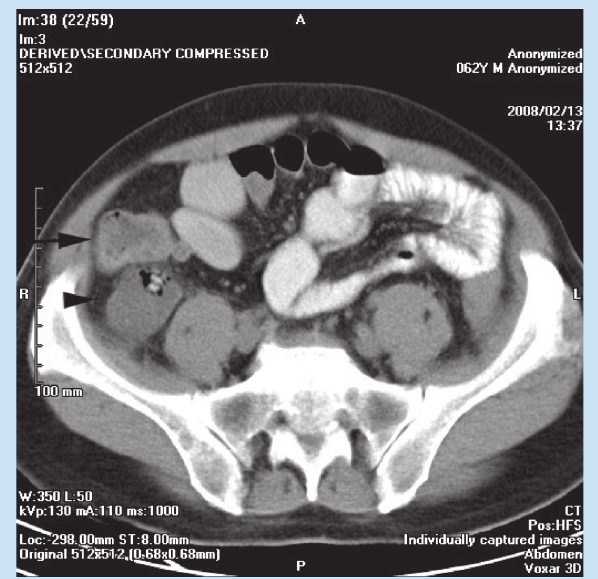
Fig. 2. CT scan of the abdomen. Retrocaecal collection (arrowhead) containing a high-density calculus consistent with an appendicolith. The caecum is indicated by the arrow. Fig. 2. is superior to Fig. 1.